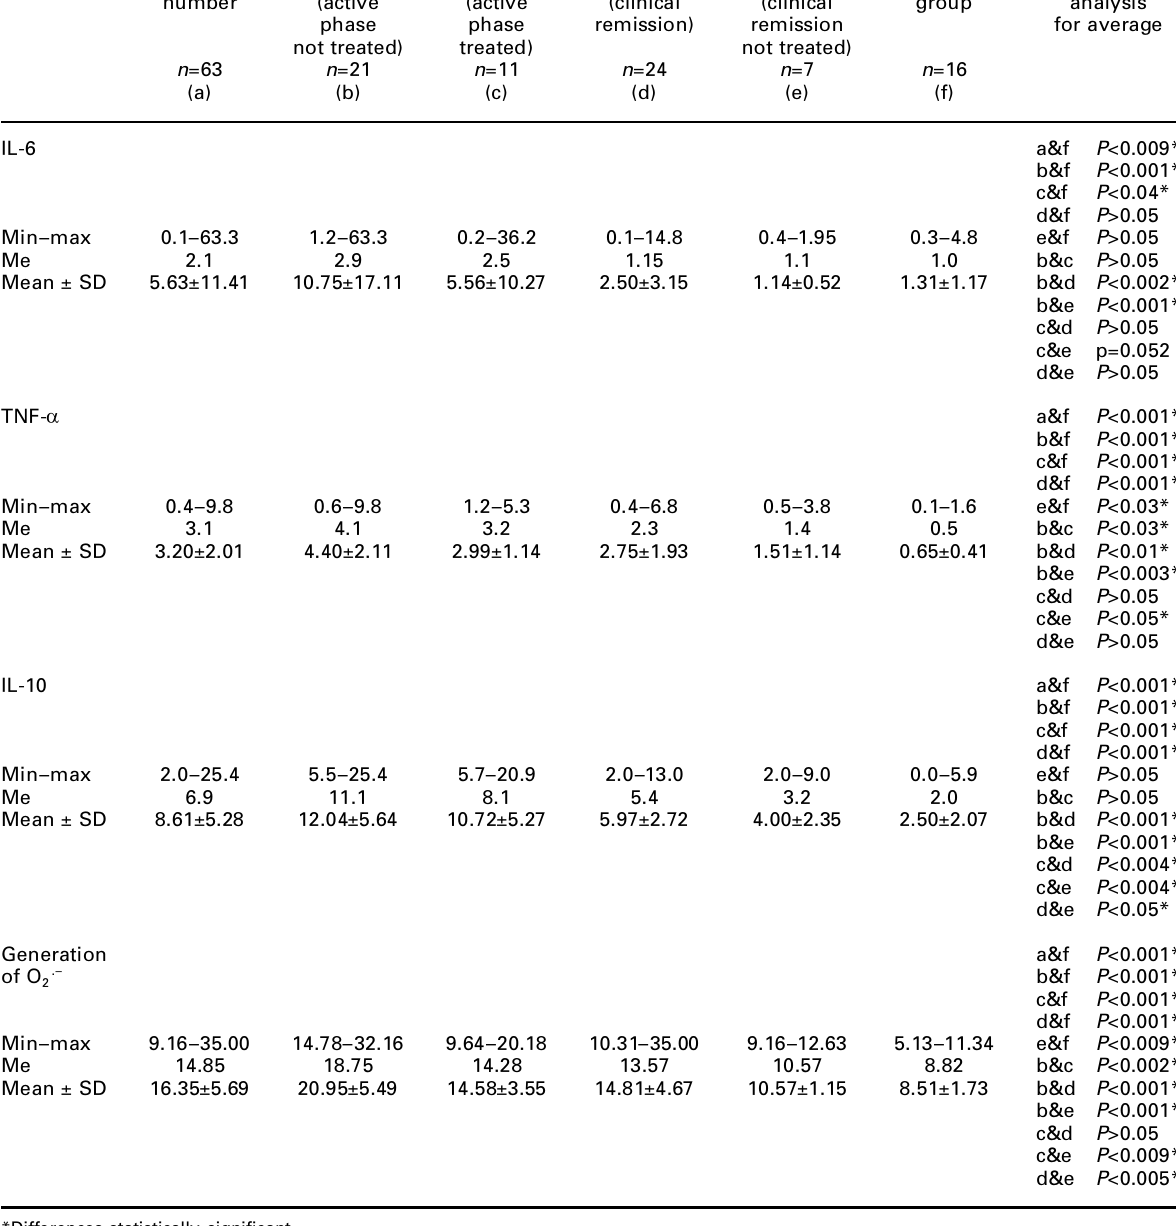
Table 3. Serum levels of IL-6, TNF- a , IL-10 and generation of O 2.– in patients with SLE and control group